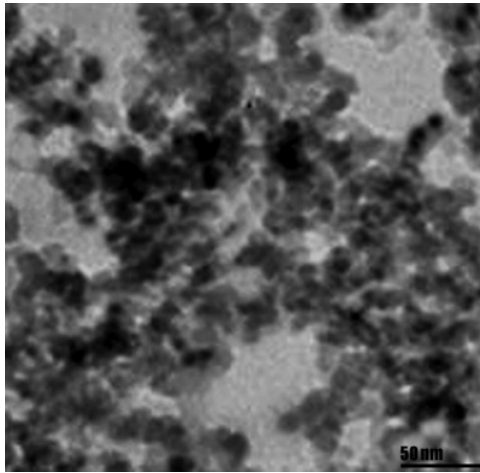
Figure 2 TEM image of AlN